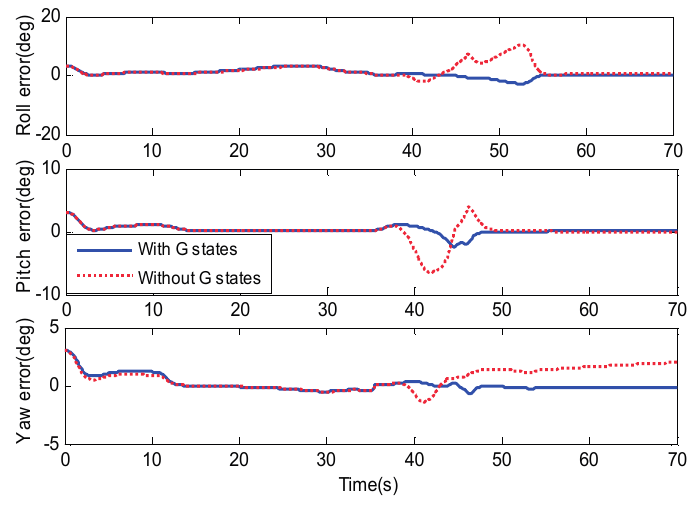
Figure 5. Estimation of the attitude errors.